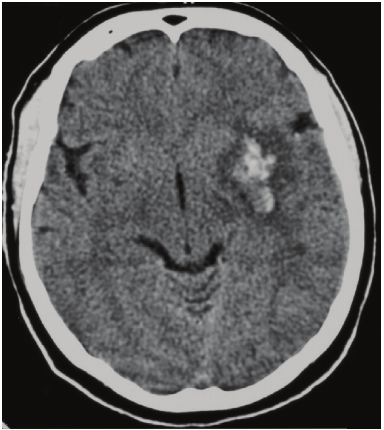
Figure 6: Control CT scan shows a small haematoma in the left